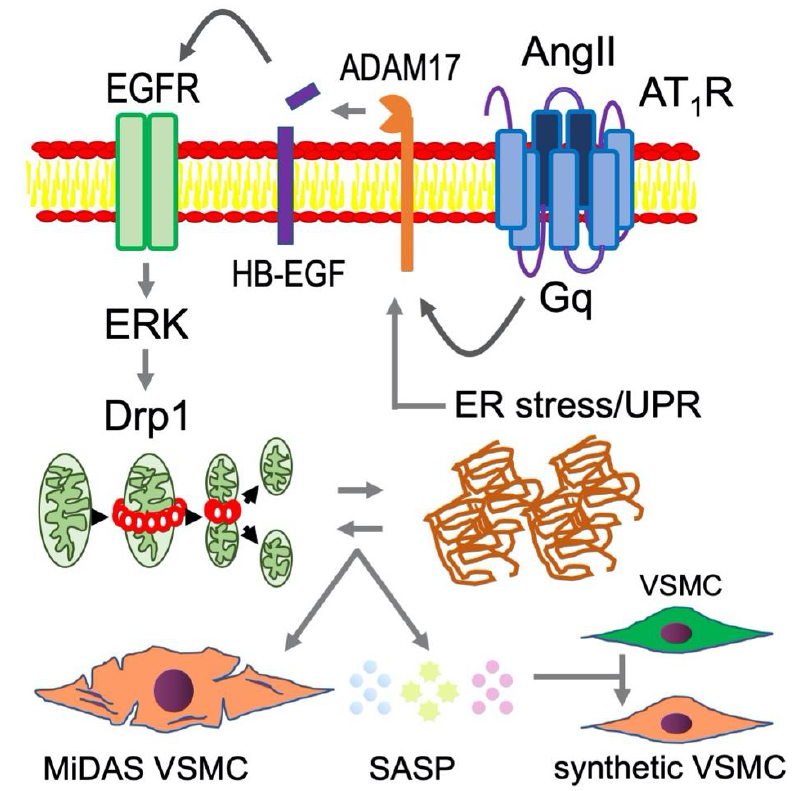
Figure 4. Mitochondrial fission and ER stress likely play upstream roles in AngII-induced vascular senescence and SASP contributing to RAS-mediated pathophysiology in CVDs. In addition to the molecular mechanisms illustrated in Figure 2, mitochondrial fission and ER stress are enhanced under chronic RAS activation contributing to VSMC senescence [6]. It is hypothesized that MiDAS VSMC produce altered SASP, which adversely affects non-senescent VSMC phenotype leading to enhancement of vascular remodeling. Such VSMC phenotype has been described as “smooth muscle cell- or arterial- stiffness syndrome” [112,113].